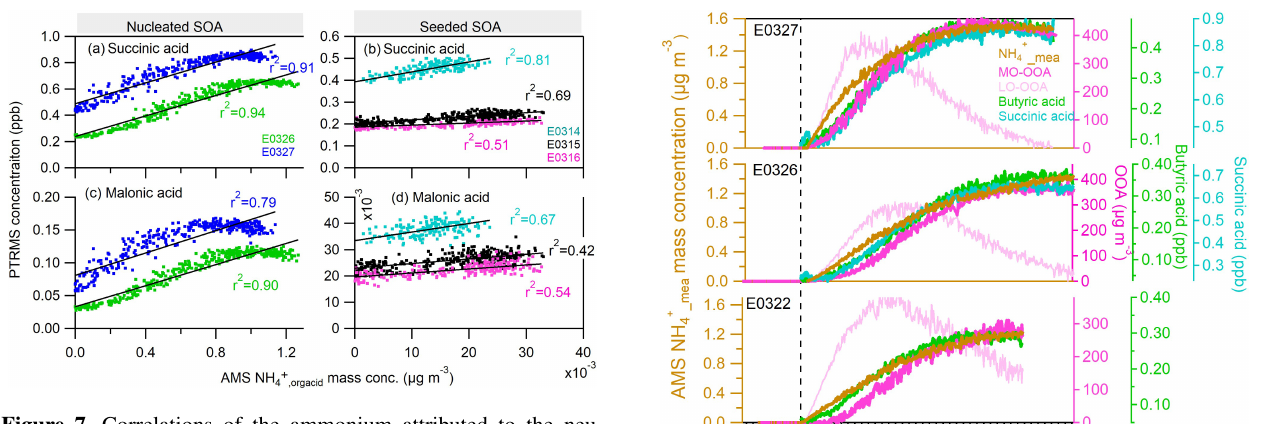
Figure 7. Correlations of the ammonium attributed to the neu- tralization by organic acids (NH + ) in the particle phase by 4 , orgacid AMS to two organic dicarboxylic acids: (a–b) succinic acid and (c– d) malonic acid in the gas phase measured by PTRMS. Neither of Figure 8. The relevance of particulate ammonium salt to the re- the diacids were observed in the experiment E0322. solved MO-OOA component by PMF, as well as to the gas-phase butyric monocarboxylic acid and succinic